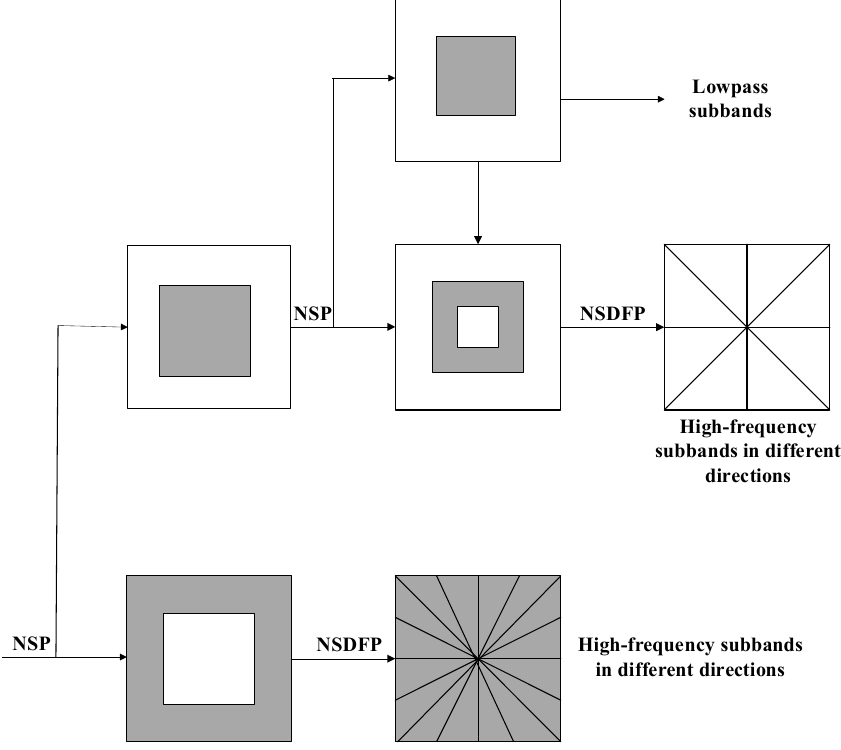
Figure 4. The decomposition flowchart of the NSCT.